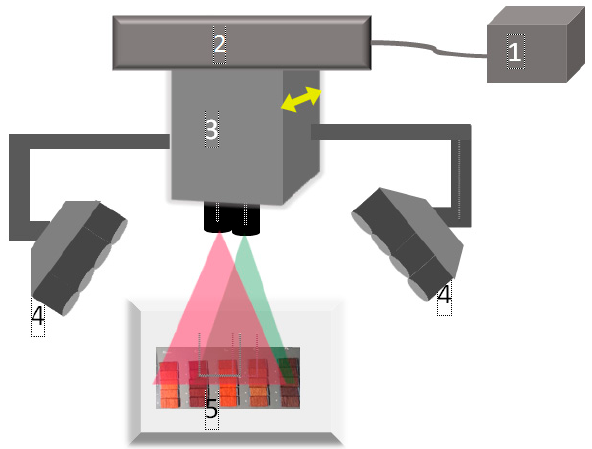
Figure 2. Schematic diagram of the spectral imaging system: (1) the control unit, (2) the linear conveyor, (3) the container of spectral cameras, (4) the halogen lamps and (5) the samples.